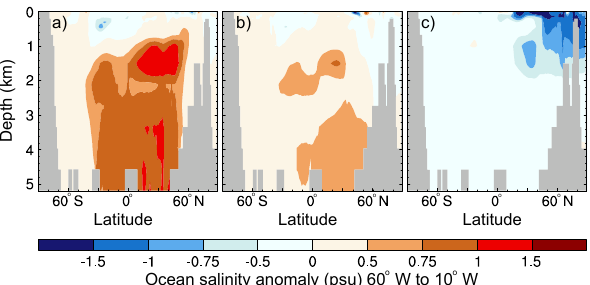
Fig. 8. Annual mean ocean salinity anomalies (inpsu) from the North to South Pole, averaged over 60 ◦ W to 10 ◦ W and given with respect to Messinian control for (a) halite-quarter , (b) gypsum-half and (c) fresh-normal . Bathymetry is masked in grey. All anomalies are given with > 95% confidence in their significance using a stu- dent t